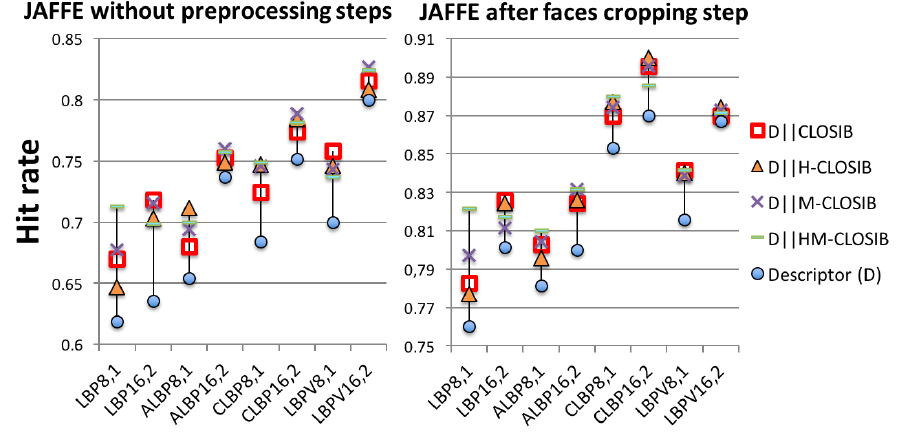
Figure 12. Results using the concatenation of LBP-based descriptors with CLOSIB variants (CLOSIB, H-CLOSIB, M-CLOSIB and HM-CLOSIB) on the original images ( left ) and the cropped ones ( right ) of JAFFE dataset.